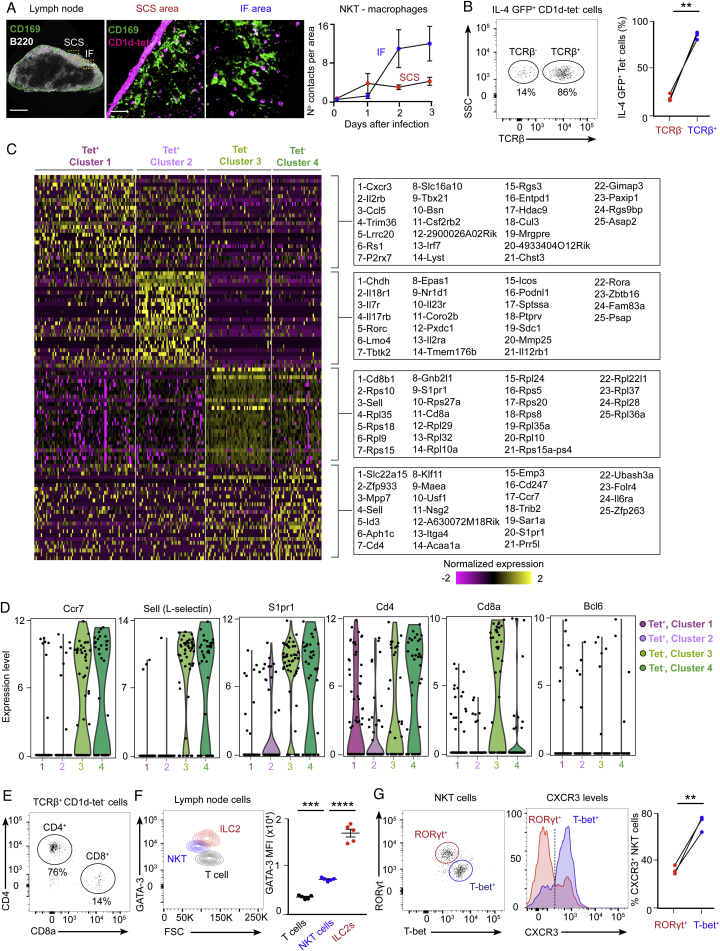
Single-Cell RNA-Seq Analysis of IL-4+ Lymph Node Cells, Related to Figure 4(A) Confocal microscopy of mediastinal lymph nodes sections at day 3 of influenza infection. Lymph nodes were labeled with PBS-57 loaded CD1d tetramer (magenta) and antibodies to B220 (white) and CD169 (green). IF, interfollicular. Scale bars, 300 μm (left); 60 μm (right). Chart on the right shows the quantification of NKT cells-macrophages contacts observed in the different areas of the lymph node at day 0, 1, 2 and 3 of infection in mediastinal lymph nodes. Data are representative from three experiments.(B) Flow cytometry analysis of IL4-GFP+ CD1d-tet- cells in mediastinal lymph nodes at day 3 of influenza infection showing TCRβ- and TCRβ + cells.(C) Single-cell RNA-seq heatmap showing the expression of 25 significant marker genes (Table S1) for the CD1d-tet+ clusters (columns 1 and 2) and CD1d-tet- clusters (columns 3 and 4). Single cells and genes were determined on the basis of unsupervised hierarchical clustering (Table S1).(D) Expression distribution (violin plots) in each population (horizontal axes) for Ccr7, Sell, S1pr1, CD4, CD8a and Bcl6. Expression levels are Log2(tpm+1).(E) Flow cytometry analysis of IL4-GFP+ TCRβ+ CD1d-tet- cells in mediastinal lymph nodes at day 3 of influenza infection showing CD4+ and CD8a + cells.(F) Representative contour plot show the expression of GATA-3 by NKT cells, ILC2s (Live/Dead- B220- CD3- CD5- CD11b- CD11c- CD127+ CD45+ GATA-3+) and CD4+ T cells at day 3 of infection. Quantification on the right chart shows the mean fluorescence intensity for GATA-3.(G) Flow cytometry analysis of RORγt+ and T-bet+ NKT cells in mediastinal lymph nodes at day 3 of influenza infection. Histogram shows the levels of CXCR3 in RORγt+ and T-bet+ populations. Dot graphs show the quantification of CXCR3+ NKT cells in the RORγt+ (red dots) and T-bet+ populations (blue dots), with lines connecting NKT cells from the same mouse.In graphs showing statistical analysis, data are representative of at least two independent experiments. Statistical analysis two-tailed Student’s t test; ∗∗p < 0.01, ∗∗∗p < 0.001 and ∗∗∗∗p < 0.0001.